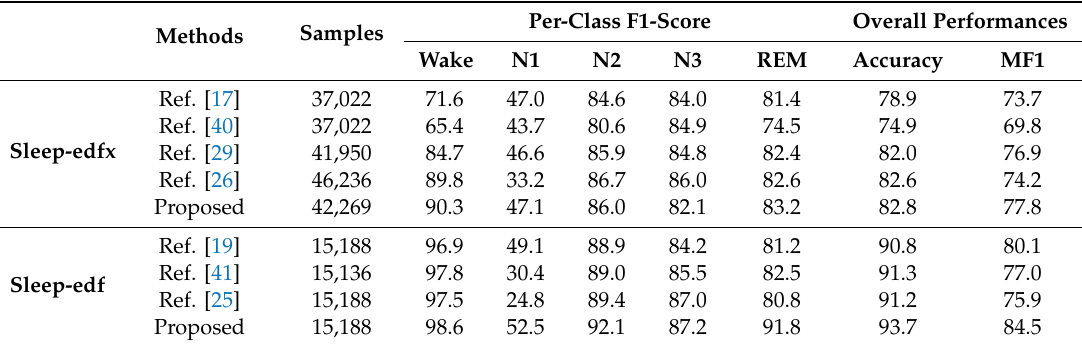
Table 6. Performance of di ff erent methods on the sleep-edf and sleep-edfx